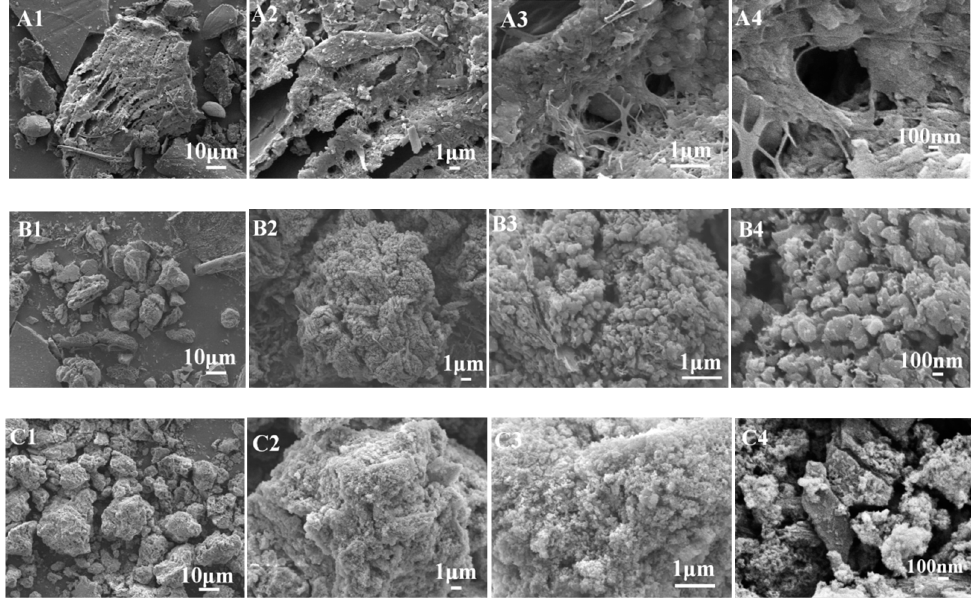
Figure 3. Observations with SEM: ( A ) PS (A1–A4: magnified ×5000, ×10,000, ×20,000, ×50,000, respectively), ( B ) CPS (B1–B4: porous microsphere-stacking structures of CPS with